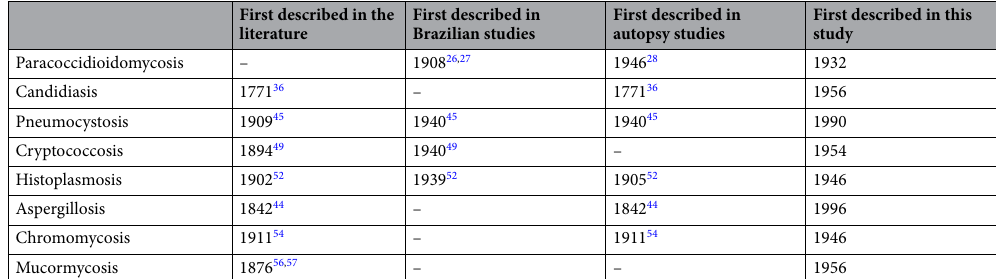
Table 2. Comparison of the year of the first description of fungal infections in the database and the first description in the literature, in Brazil and worldwide, when data were available. Data were obtained from PubMed, the website https ://www.cdc.gov/funga l/disea ses, and Google Scholar in the English, Spanish and Portuguese languages.